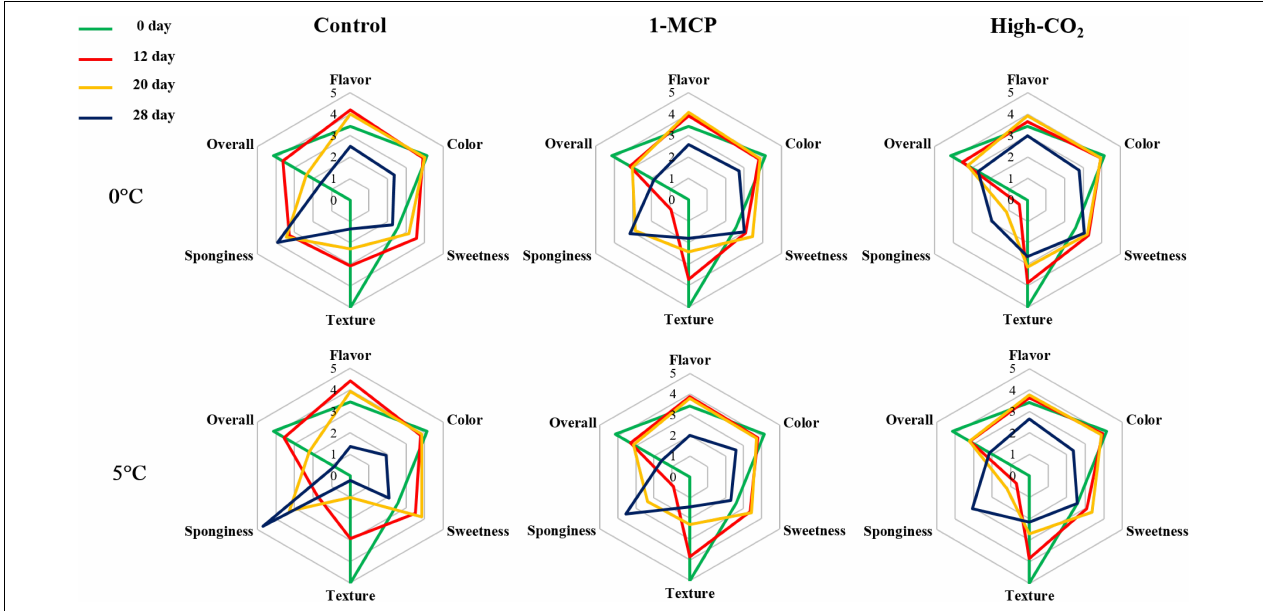
FIGURE 4 | Sensory qualities of Madoka peach fruit at harvest (0 day) and during storage up to 28 day at 0 and 5 ◦ C with prestorage high CO 2 and 1-MCP treatments or without treatment (control). Data are presented as the mean value of the subjective scale from bad (1) to excellent (5) made by 10 graduate students as panelists.